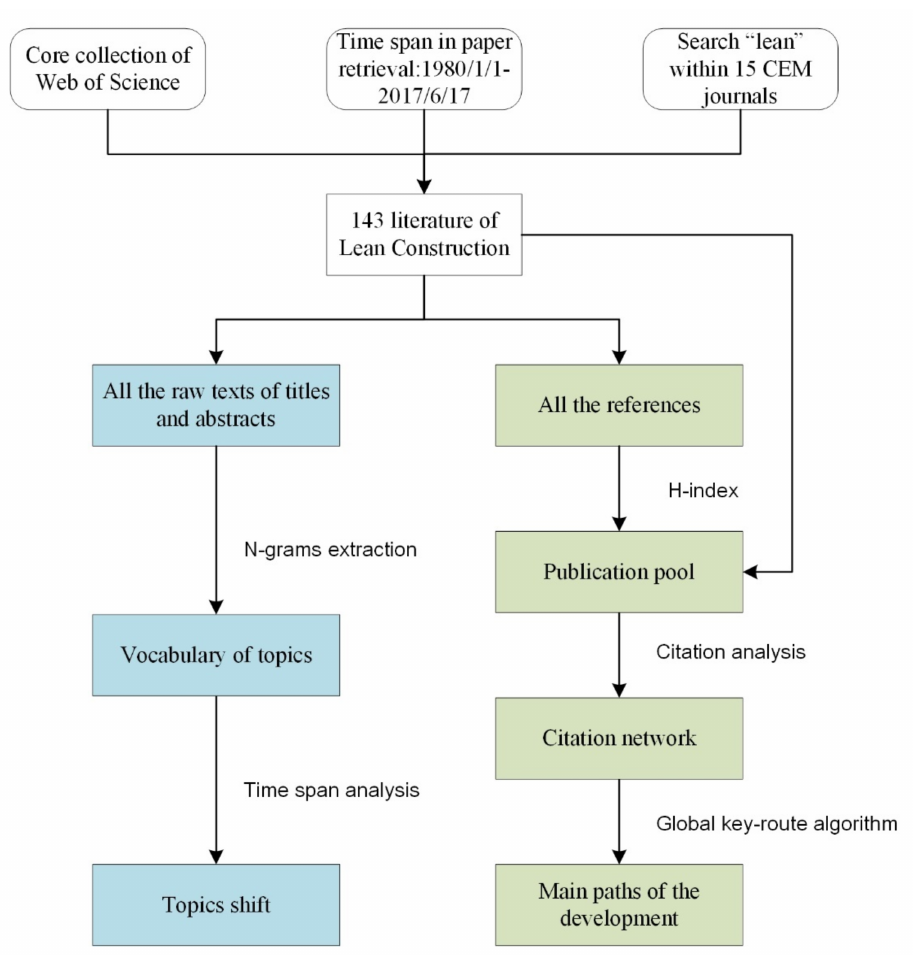
Figure 1. The analysis procedures of this